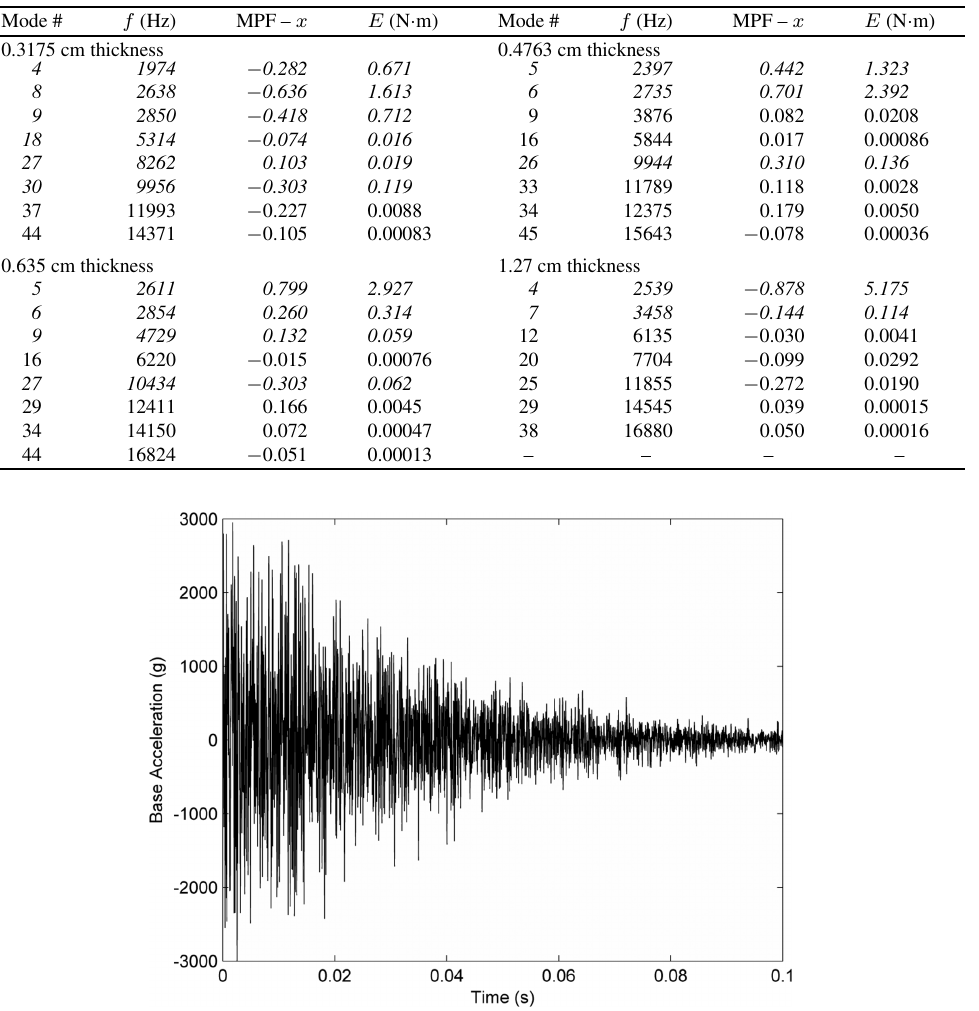
Fig. 9. Nominal base acceleration applied to structure from Fig.